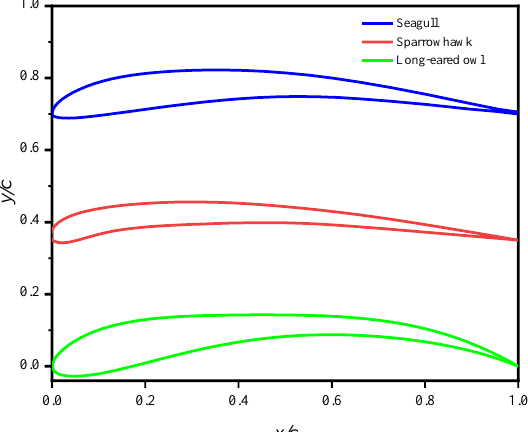
Figure 2. Airfoil models of the seagull, sparrowhawk and long-eared owl. Some studies have applied the profiles of seagulls, sparrowhawks, and long-eared owls to turbines and fan blades and obtained satisfactory results. Tidal turbine blades typically require 3 – 5 airfoils for stacking along their tidal spreading direction. Therefore, the airfoils of the seagull, long-eared owl, and sparrowhawk were selected as initial air- foils for optimization. The relative thickness, camber, and trailing edge thickness of the three initial airfoils were different. The parameters of the three airfoils were optimized to achieve the same objectives and compared under the same constraints to determine whether the airfoils were suitable for turbine operating environments. This is further dis- cussed in Section 4.